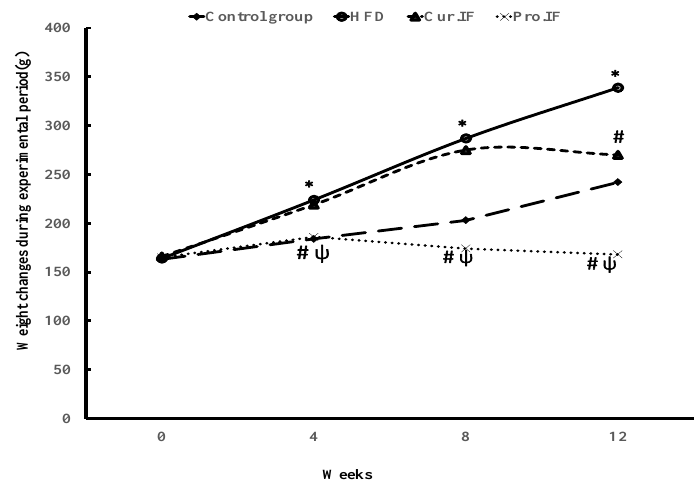
Figure 2. Effect of HFD and/or intermittent fasting on rats’ body weights: Rats were fed either (a) basal (normal control group) diet; (b) HFD; (c) pro. IF; rats were subjected to both IF and HFD for 12 weeks; or (d) cur. IF; rats were subjected to HFD for 8 weeks then IF simultaneously with HFD during last 4 weeks. Rats’ body weights were recorded after 4, 8 and 12 weeks from the beginning of the experiment. In all studied groups * HFD significant vis. control group, # pro. and cur. IF significant vis. HFD group, ψ pro. IF significant vise cur. IF.